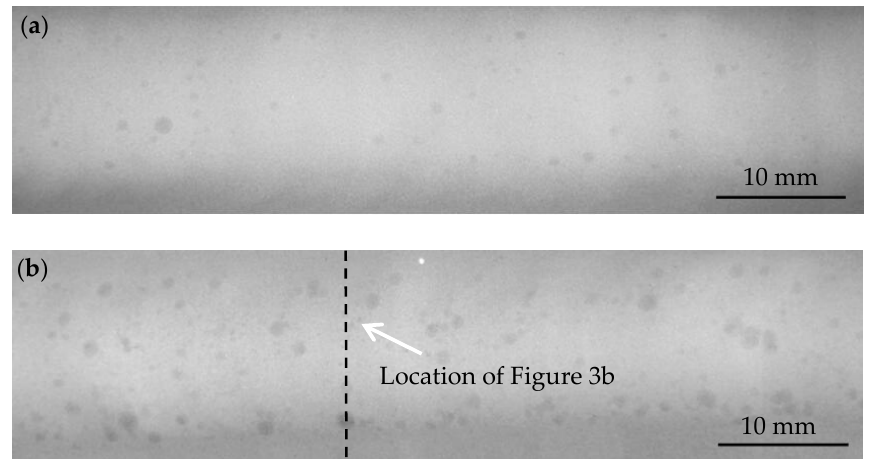
Figure 2. Nondestructive testing (NDT) photographs of representative welded joints: ( a ) sample No. 4; ( b ) sample No. 6.